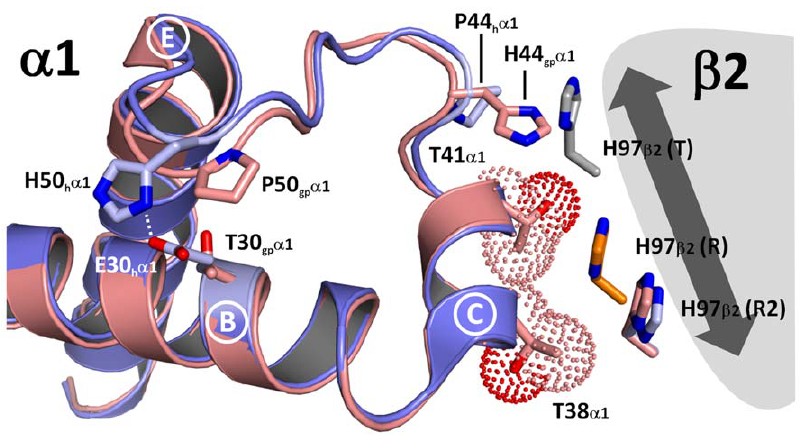
Figure 3. The ‘‘Switch’’ region of the a 1/ b 2 interface in guinea pig hemoglobin. The switch region at the a 1/ b 2 interface in guinea pig hemoglobin shows two important differences in comparison with human hemoglobin in the R2-state. Firstly, the stabilizing salt bridge, which connects Glu30 and His50 in human hemoglobin, is missing due to an amino acid exchange in guinea pig hemoglobin. Secondly, a steric hindrance between His97 of the b 2-subunit and His44 of the a 1-subunit might render the T-state of guinea pig hemoglobin less stable than the T-state in human hemoglobin, which has a Pro44 in the a 1-subunit. Due to this steric hindrance a relaxed state conformation (R- or R2-state) of guinea pig hemoglobin could be favored, thereby increasing its oxygen affinity. The a 1- and b 2-subunit of guinea pig hemoglobin ( a 1=light red) and human hemoglobin ( a 1=light blue) in the R2-state (PDB-code: 1BBB, [10]) were superimposed according to their C a -atoms. Carbon atoms of amino acids in guinea pig hemoglobin are colored light red, while the carbon atoms are colored blue in human hemoglobin. The position of the b 2-subunit is denoted by a light grey area, while the sliding movement of His97 in the course of the conformational transition is illustrated by an arrow (dark grey). The position of His97 in the R2-state of guinea pig hemoglobin is colored in light red. Furthermore the position of His97 in human hemoglobin is shown in the T-state (grey, PDB-code: 1A3N, [36]), R-state (orange, PDB-code: 1HHO, [37]) and R2-state (light blue, PDB-code: 1BBB, [10]).